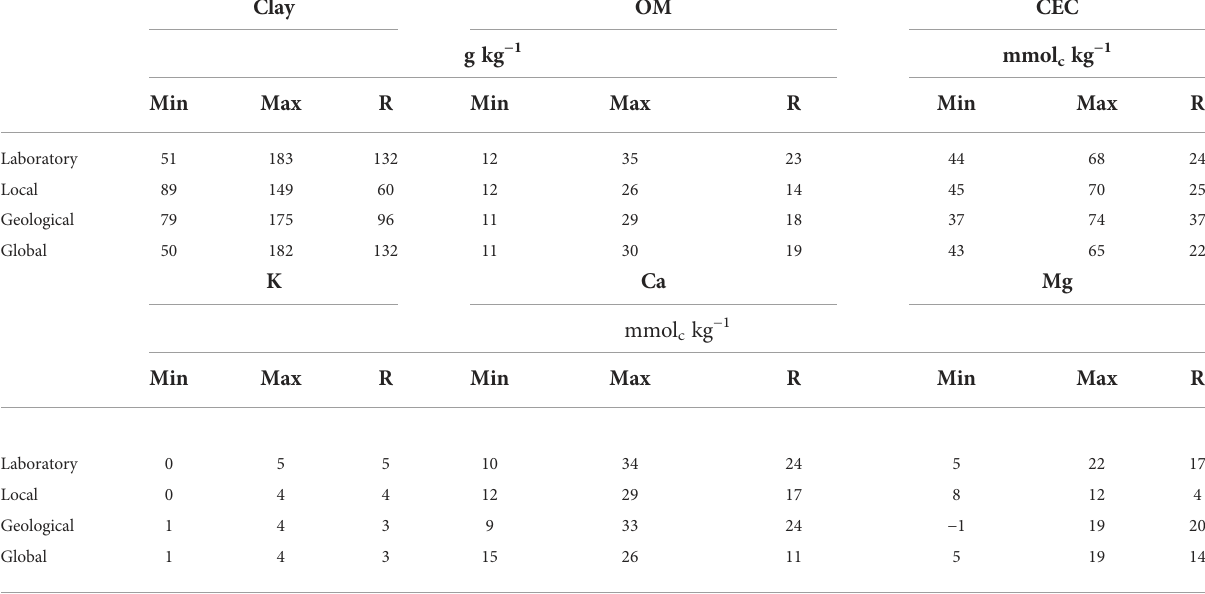
TABLE 2 Range of values observed for clay, organic matter (OM), cation exchange capacity (CEC), potassium (K), calcium (Ca), and magnesium (Mg) in laboratory analysis (Lab), and predicted values using online spectrum of experimental fi eld from three different calibration strategies of only in- fi eld samples (local), adding samples from the same geological region (Geo), and from different geological regions